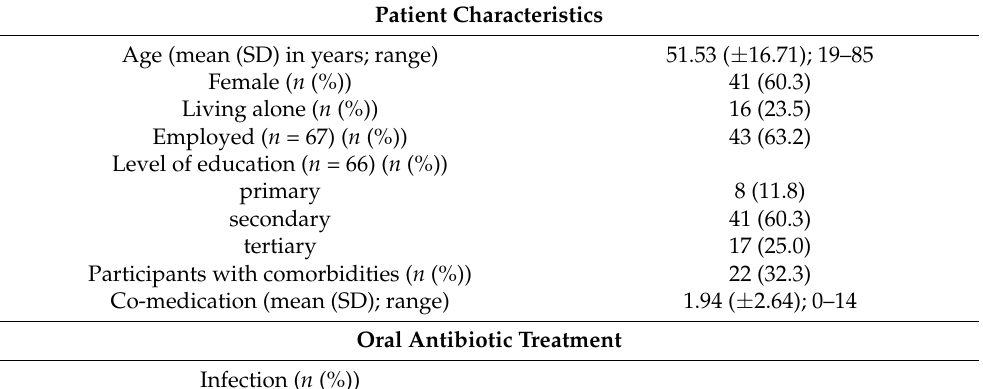
Table 1. Demographic information and characteristics of the prescribed antibiotic treatment for patients of the construct validity study ( n =